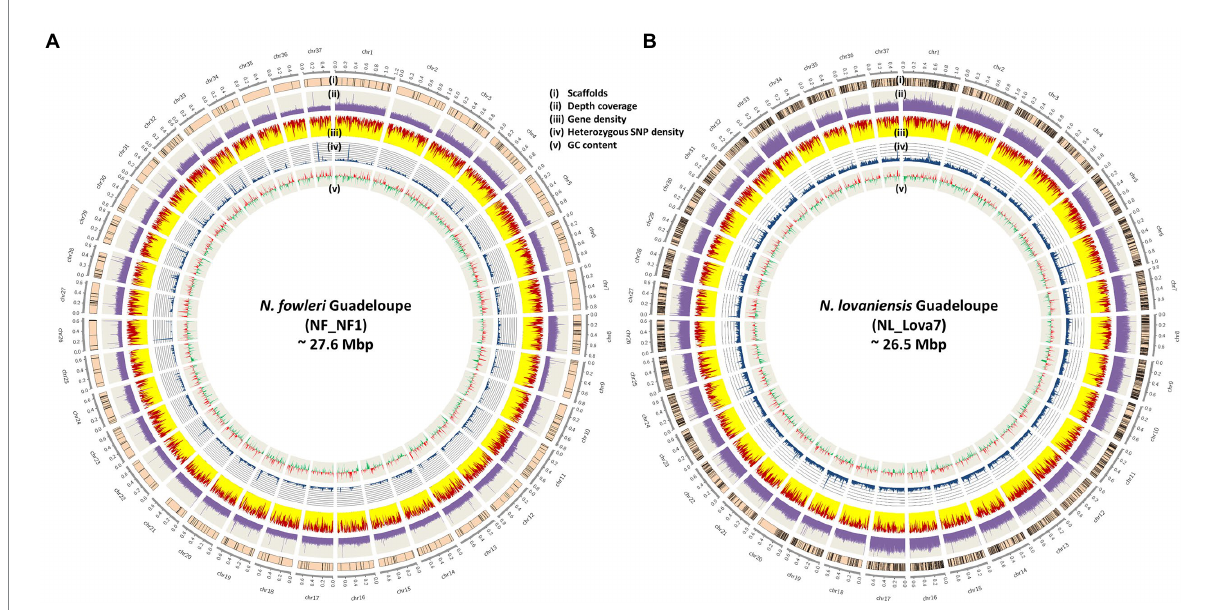
FIGURE 2 Architecture of the new genomes of Naegleria fowleri (A) and Naegleria lovaniensis (B) The outer circle represents the 37 chromosomes and their size. From outside to inside: (i) scaffolds anchoring (scaffolds were anchored and ordered using RaGOO program), (ii) sequencing depth of coverage in purple, (only one replicate (NF_NF1_1) is used for N. fowleri, both are plotted on a 200X scale), (iii) gene distribution (the relative part of exons and introns is colored in yellow and red respectively), (iv) heterozygous SNP density in blue and (v) GC skew (positive GCskew value in red, negative GCskew value in green). All density and distribution plots are based on 10-kb sliding